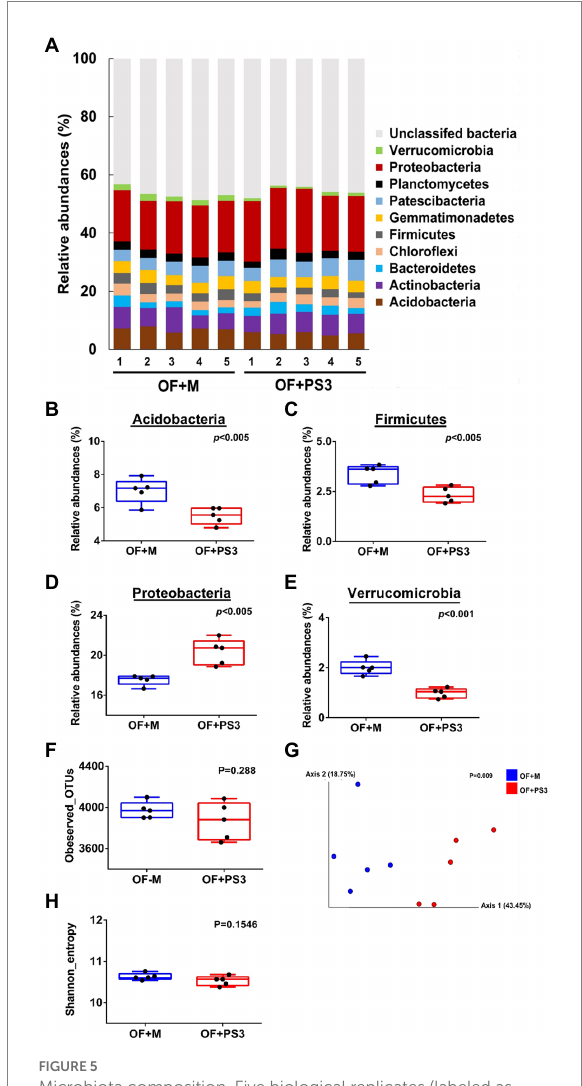
FIGURE 5 Microbiota composition. Five biological replicates (labeled as 1–5) were used for each set. (A) Relative abundance at the phylum level; only those accounting for at least 1.0% are labeled, and the remainder is grouped under “unclassified bacteria.” (B–E) Bacterial phyla exhibiting significant differences in relative abundance between different treatments ( p < 0.05); alpha- diversity includes (F) observed OTUs and (G) mean species richness (Shannon index); beta-diversity indicated by (H) principal coordinate analysis (PCoA) based on weighted UniFrac distance; Blue dots represent full rate organic fertilizer with nutrient medium (OF + M). Red dots indicate full rate organic fertilizer with PS3 inoculum (OF + PS3). A data point denotes one sample or biological repeat. Each treatment consisted of five biological